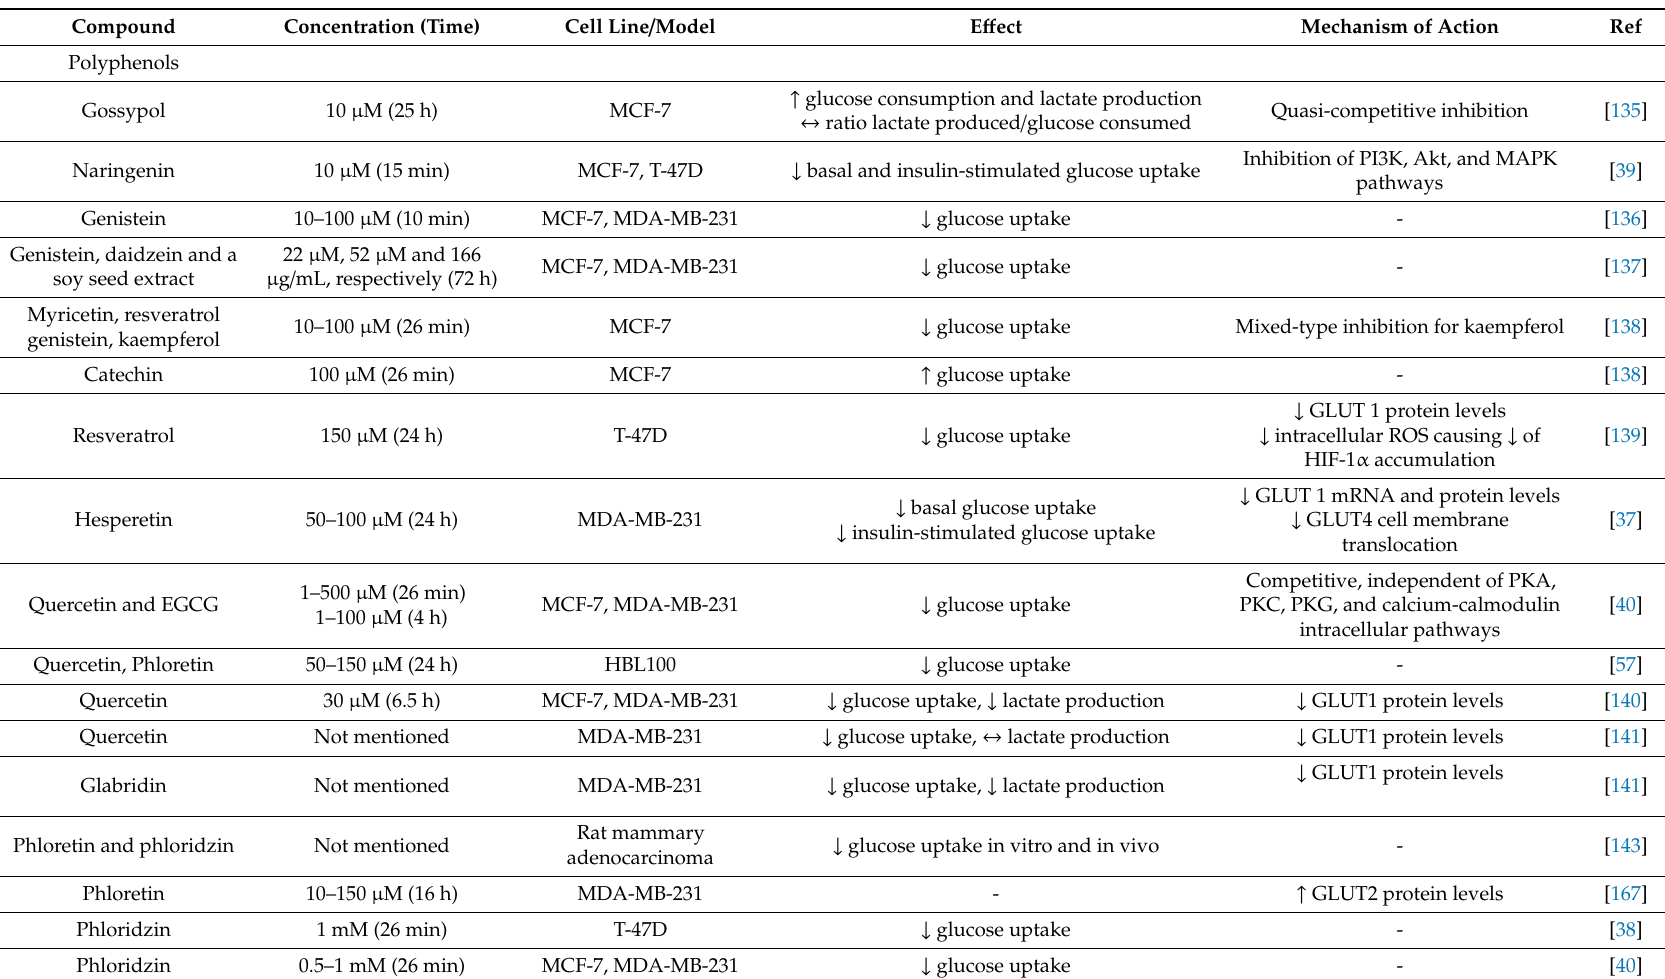
Table 3. E ff ect of exogenous compounds on glucose uptake by breast cancer